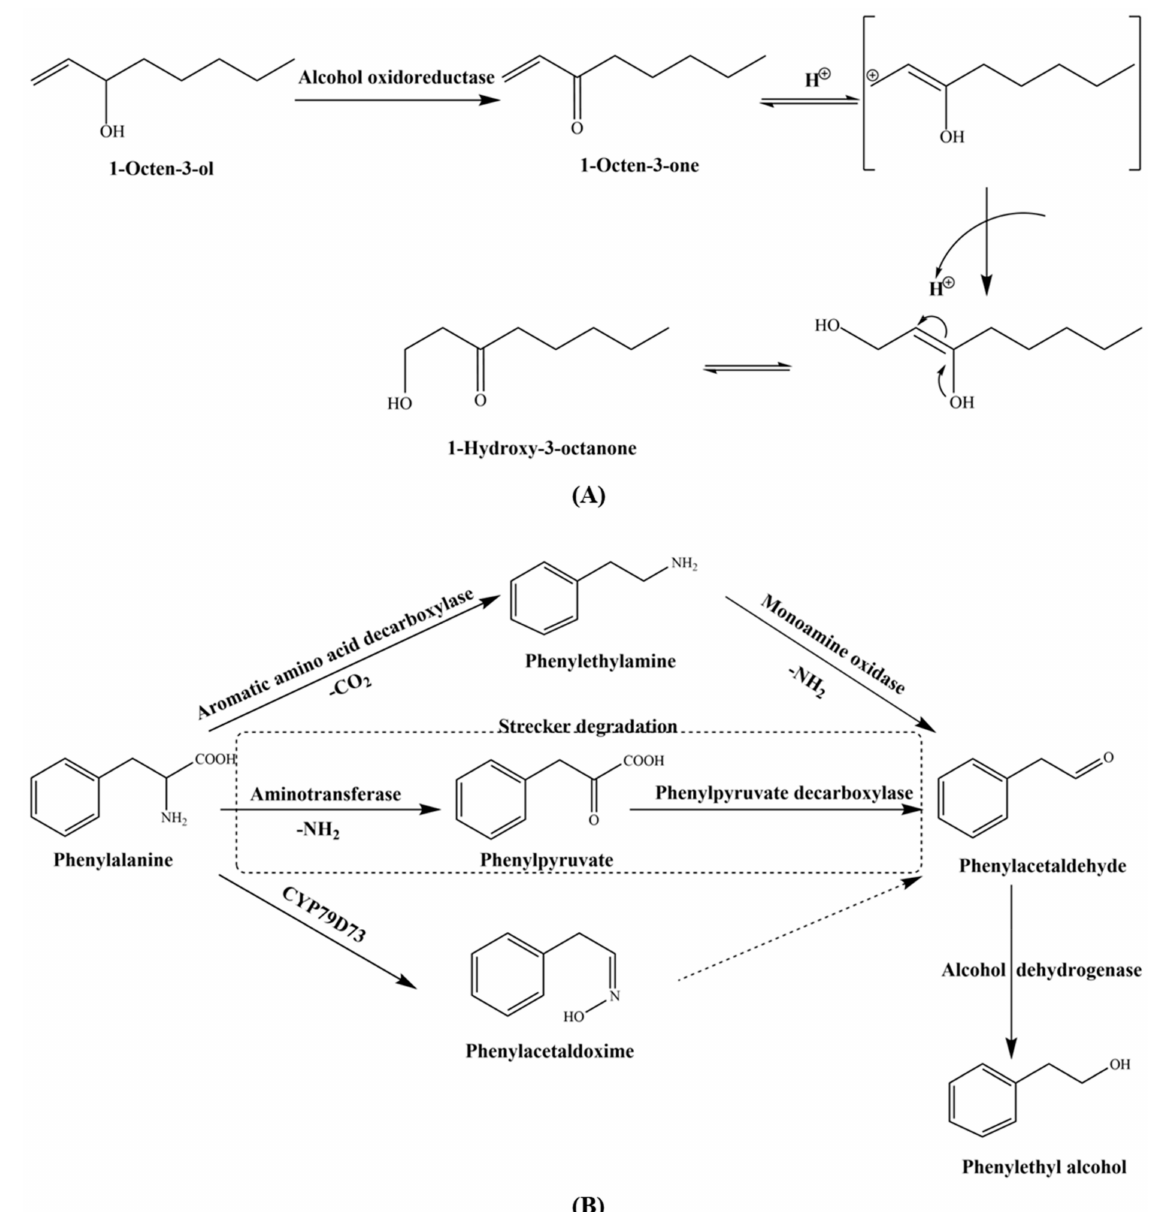
Figure 5. Main pathways involved in the degradation of 1-octen-3-ol ( A ) and the formation of phenylethyl alcohol ( B ) in shiitake mushrooms during